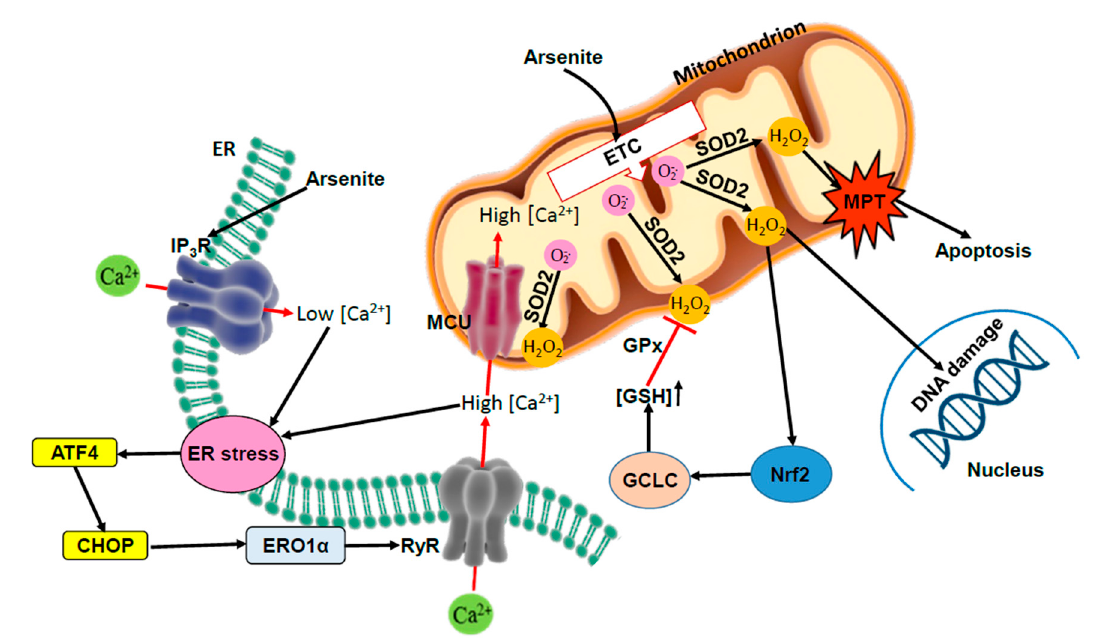
Figure 1. Crosstalk between arsenite-induced mitochondrial ROS, ER stress, and Nrf2. Arsenite pro- motes mitoO 2 − . formation via a mechanism requiring interactions with the mitochondrial respiratory chain and an accumulation of Ca 2+ in these organelles. The metalloid initially stimulates Ca 2+ release from the IP 3 R, which, although not directly taken up by the mitochondria, nevertheless contributes to this event via RyR stimulation. Indeed, due to the close apposition with the mitochondria, only the fraction of Ca 2+ the RyR can be taken up by the mitochondria. Cells uniquely expressing the IP 3 R, in which these channels are in close contact with the mitochondria, failed to generate mitoO 2 − . in response to arsenite. RyR activation was regulated by ERO1 α and the resulting mitochondrial accu- mulation of Ca 2+ was critical for the formation of mitoO 2. . In this perspective, while the ER stress response appears upstream to mitoO 2 − . formation, it is nevertheless reasonable to predict that per- sistent mitoO 2 − -derived H 2 O 2 promotes mitochondrial dysfunction and toxicity. The early ER stress response was also critically connected through mitoO 2. formation with the triggering of the Nrf2 cytoprotective signaling, which indeed significantly mitigated and delayed the onset of MPT-de- pendent apoptosis.